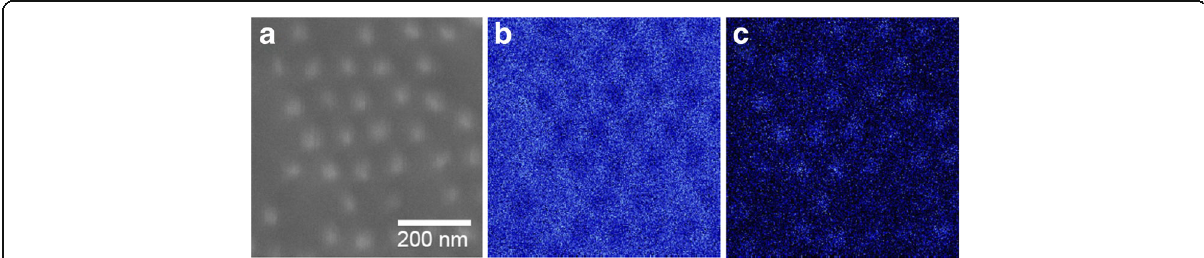
Fig. 6 a Image of GaAs substrate after Au-assisted chemical etching and corresponding AES maps for b Ga and c Au. The etching conditions were the same as those in Fig.